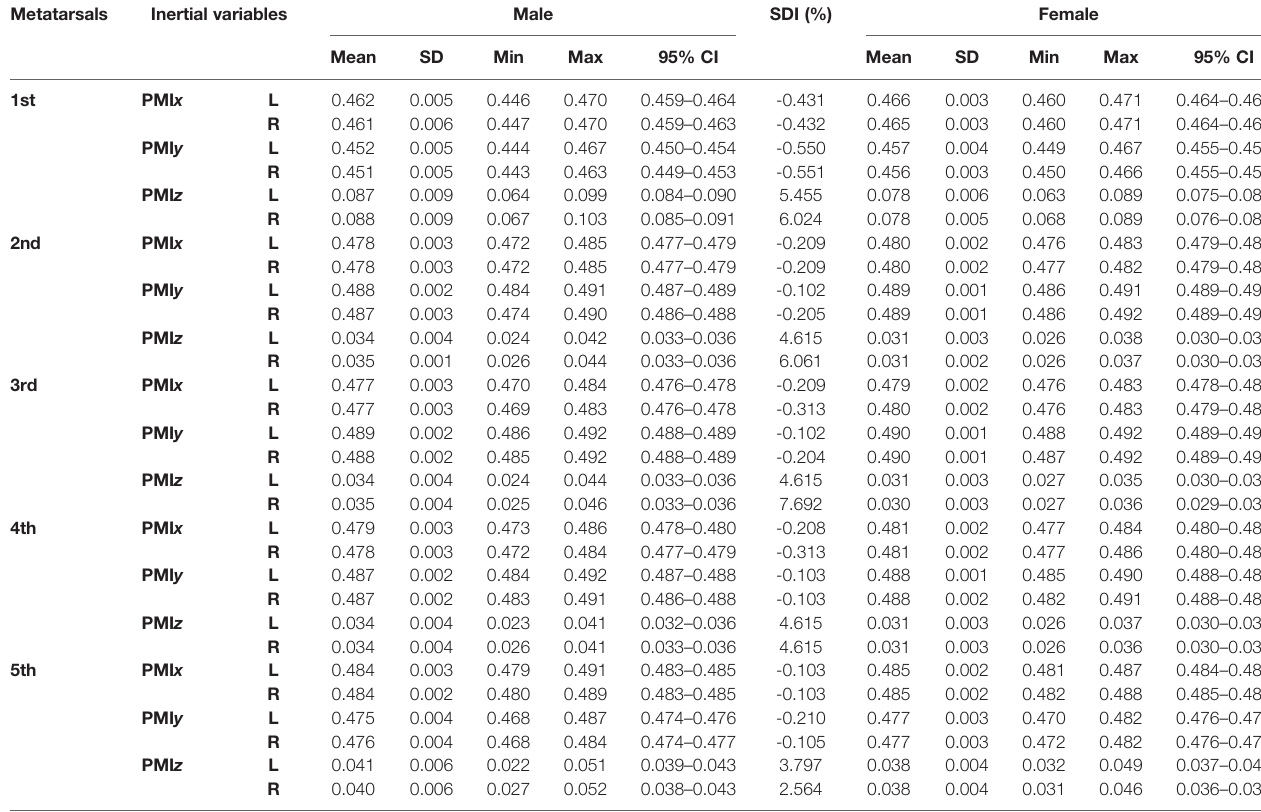
TABLE 3 | Descriptive results of three normalized PMIs of metatarsal bone in vivo based on its PAI. Metatarsals Inertial